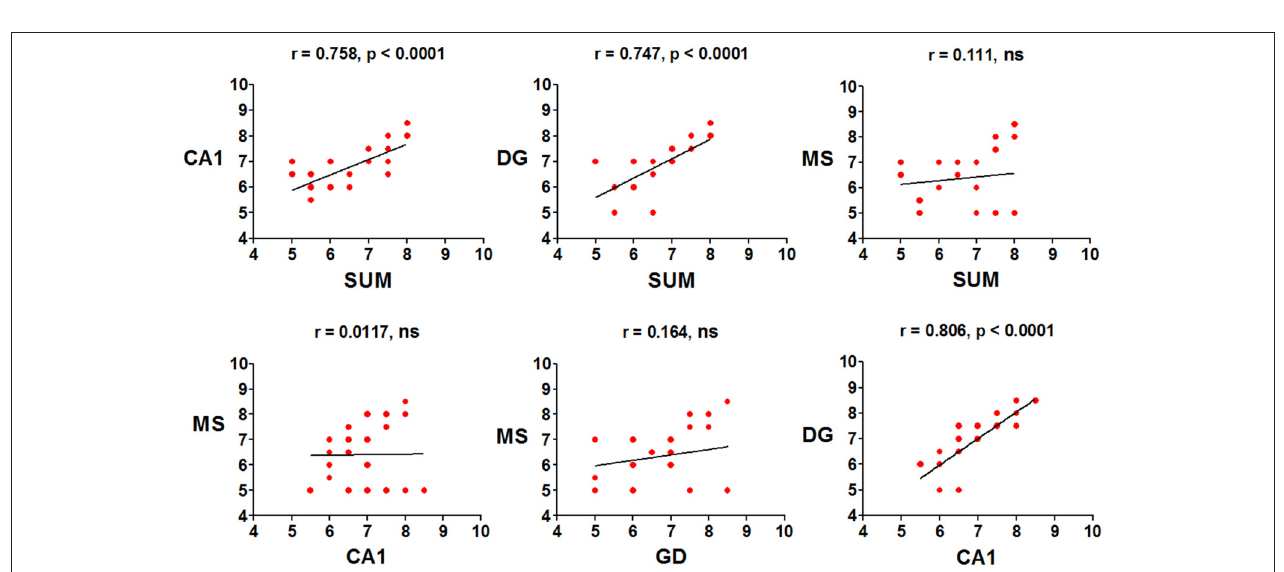
FIGURE 7 | Correlations of the mean frequency peak of the RP in the theta band (5–10Hz) between recorded regions, across training days, in the EXP group. Significant positive correlations between the SUMn and the hippocampus and within the hippocampus (DG and CA1), were observed. No correlation between the MS and the other two regions occurred in this group (ns, no